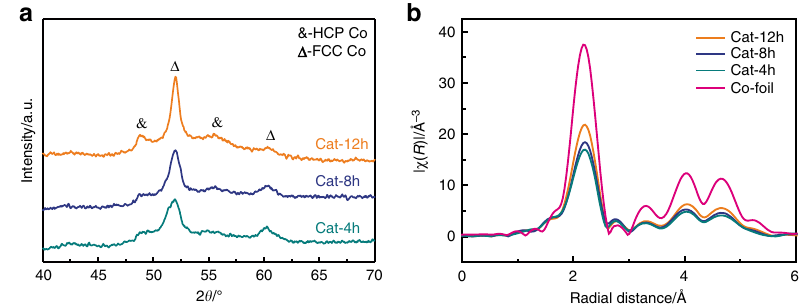
Fig. 2 Structure of the reduced catalysts. a XRD patterns of the reduced Cat- x h catalysts. The crystallite sizes of metallic cobalt in the reduced catalysts are estimated to be 10.2, 8.2, 6.5 nm based on the Scherrer ’ s equation. b RDFs spectra of the reduced catalysts and the reference Co foil